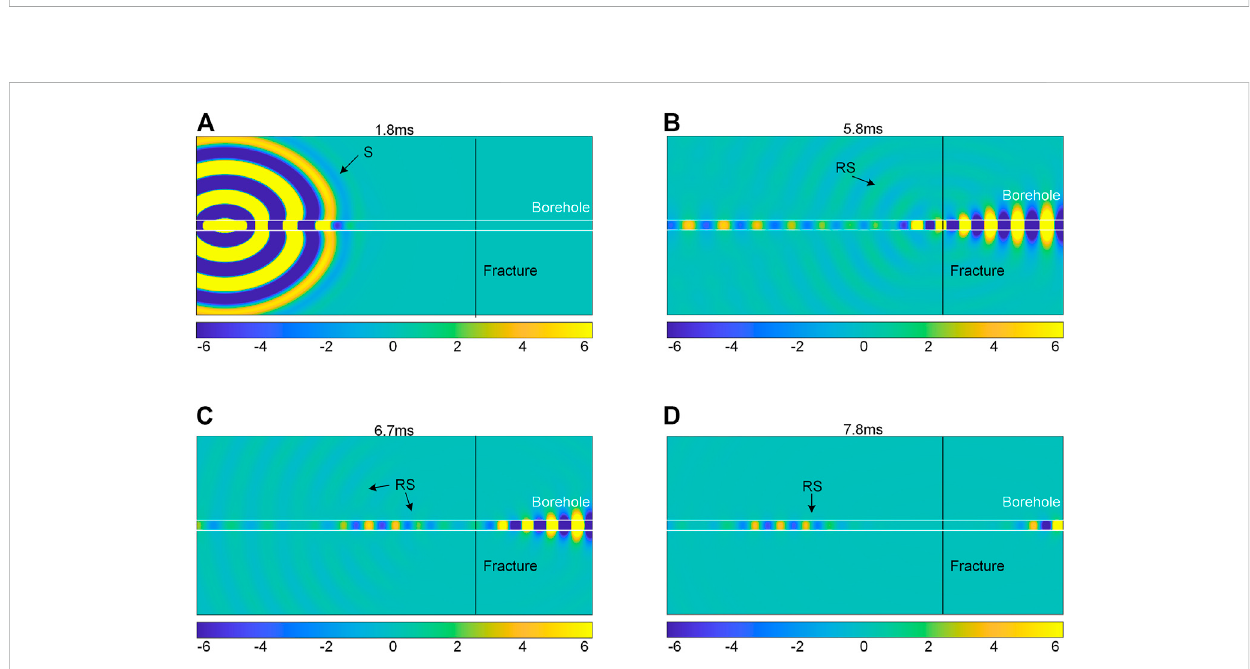
FIGURE 5 Wave fi eld slice of the S wave excited by a dipole sound source. The color scale at the bottom of the fi gure describes the wave energy distribution. Yellow andbluerespectively correspondtothepeakand troughenergyoftheSwave. Thefracturedipangle is90 ° , thefracturewidthis40 mmand fi lled with calcite. (A) 1.8 ms; (B) 5.8 ms; (C) 6.7 ms; (D) 7.8